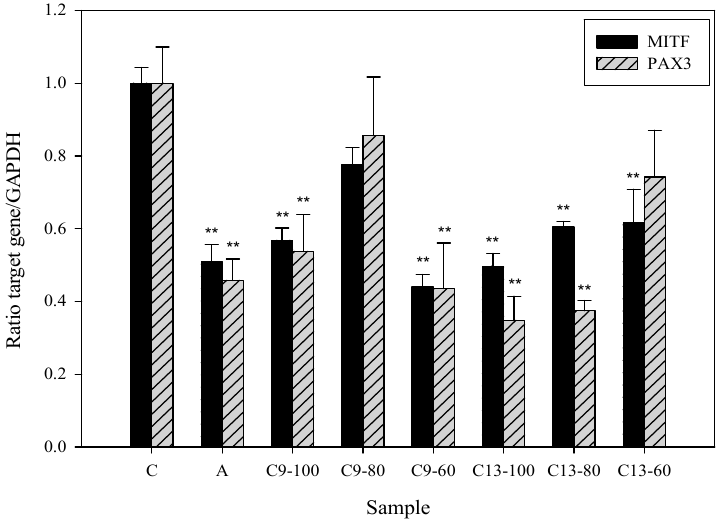
Figure 5. Real-time PCR analysis of microphthalmia-associated transcription factor (MITF) and Paired box 3 (PAX3) in human epidermal melanocytes treated with 3,6-dihydroxy-2,4-dimethoxy-dibenzofuran ( 9 ) and 3,4-dihydroxy-5-methoxybiphenyl-2 ′ - O - β - D -glucopyranoside ( 13 ). Cells (1 × 10 6 ) were treated with different concentrations (100, 80, and 60 μ M) of compounds 9 and 13 for 24 h. Quantification of gene transcripts was performed using a LightCycler ® 480 TaqMan according to the manufacturer’s instructions. Findings were normalized to the expression of GAPDH mRNA. Measurements were conducted in triplicate, and mean expression values for test samples relative to mean expression values for negative controls are indicated. C: control, A: arbutin (2.5 mM), C9: 3,6-dihydroxy-2,4-dimethoxy-dibenzofuran ( 9 ), C13: 3,4-dihydroxy-5-methoxybiphenyl-2 ′ - O - β - D - glucopyranoside ( 13 ). Differences in data were evaluated for statistical significance (** p < 0.001) with the Student’s t -test.